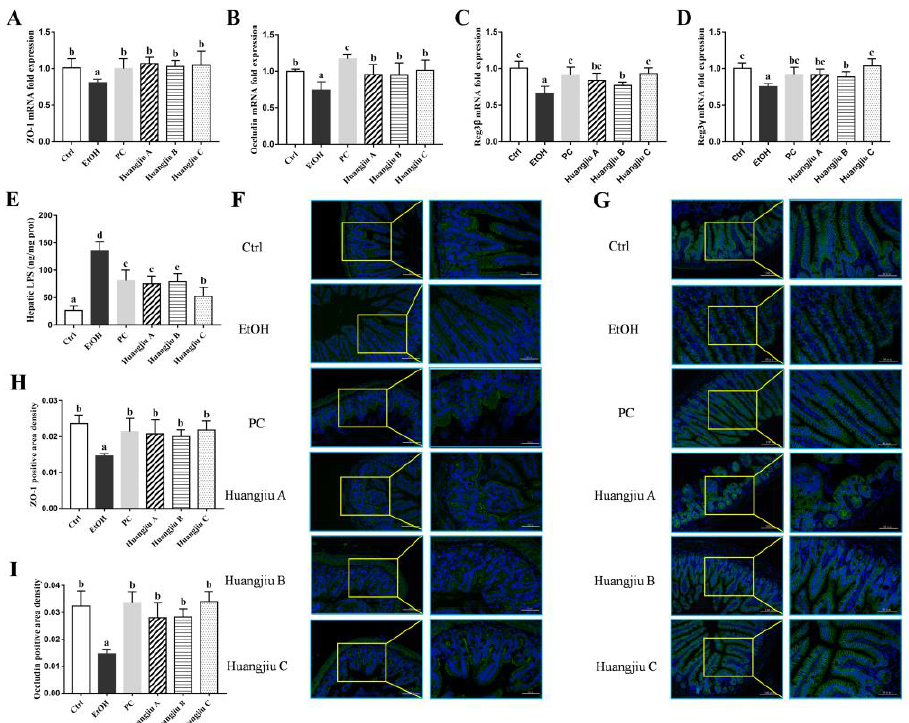
Figure 3. Effects of Huangjiu interventions on intestinal barrier functions in mice. The mRNA expression levels of ileum ZO-1 ( A ), occludin ( B ), Reg3 β ( C )and Reg3 γ ( D ) were determined by RT-qPCR using GAPDH as an internal control. ( E ) Levels of hepatic LPS. Representative images and quantified fluorescence intensity of immunofluorescence analysis of ZO-1 ( F , H ) (green) and occludin ( G , I ) (green) in ileum of mice. Nuclei were stained with DAPI (blue). Magnification × 200 and × 400. Bar plot shown as mean ± standard deviation (SD) ( n = 10). Different lowercase letters indicate statistically significant differences ( p < 0.05) between the groups using one-way ANOVA followed by Fisher’s LSD test. LPS, lipopolysaccharides.